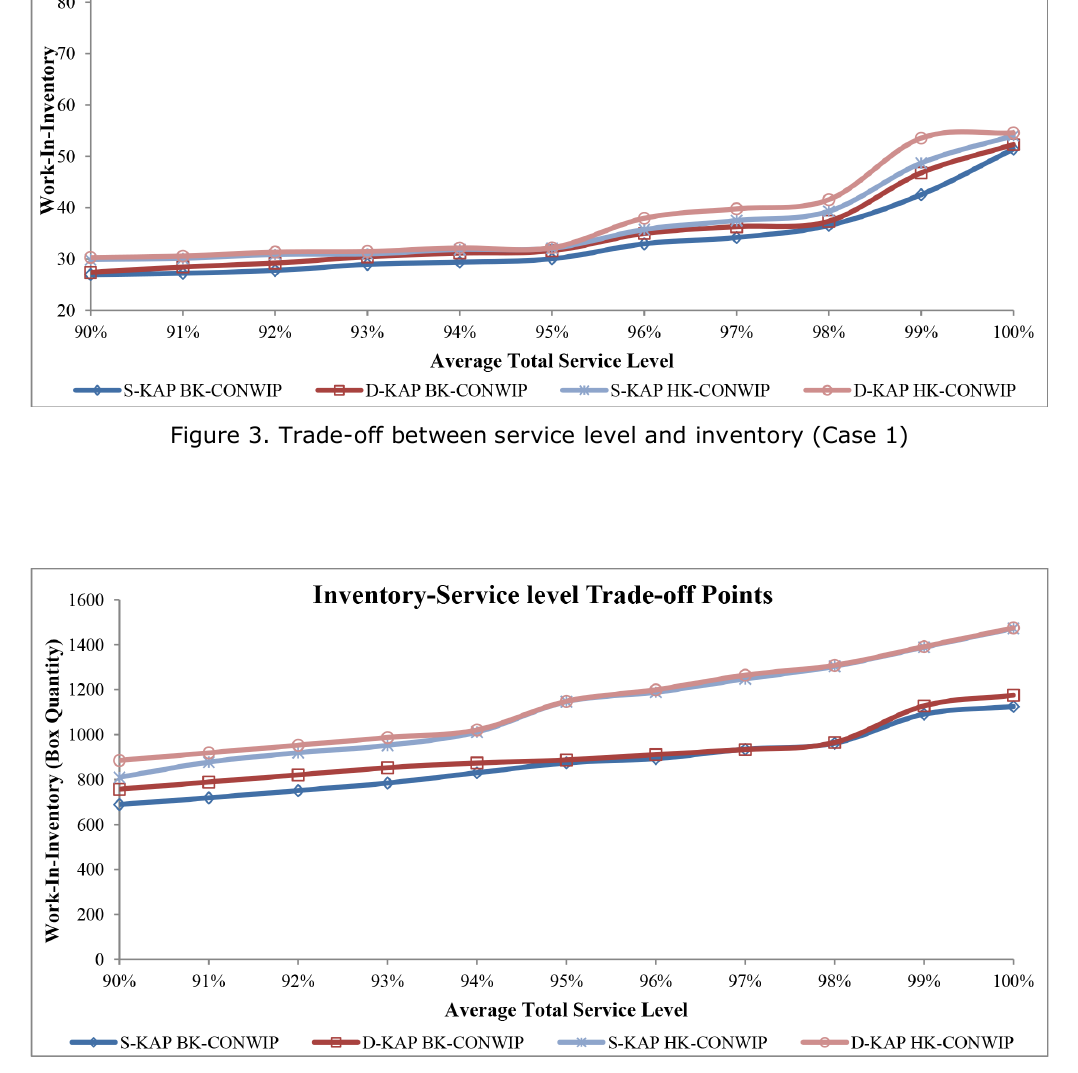
Figure 4. Trade-off between service level and inventory (Case 2)